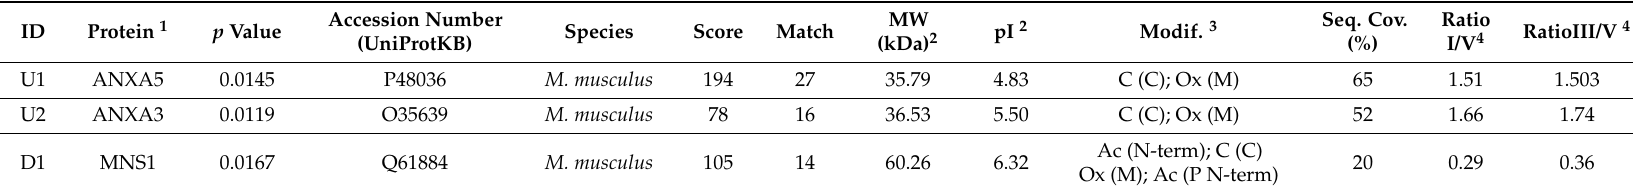
Table 1. Significantly ( p ≤ 0.05) differentially expressed proteins in feline fibrosarcomas from the FFS1 and FFS3 cell lines versus the FFS5 cell line identified by MALDI-TOF MS.